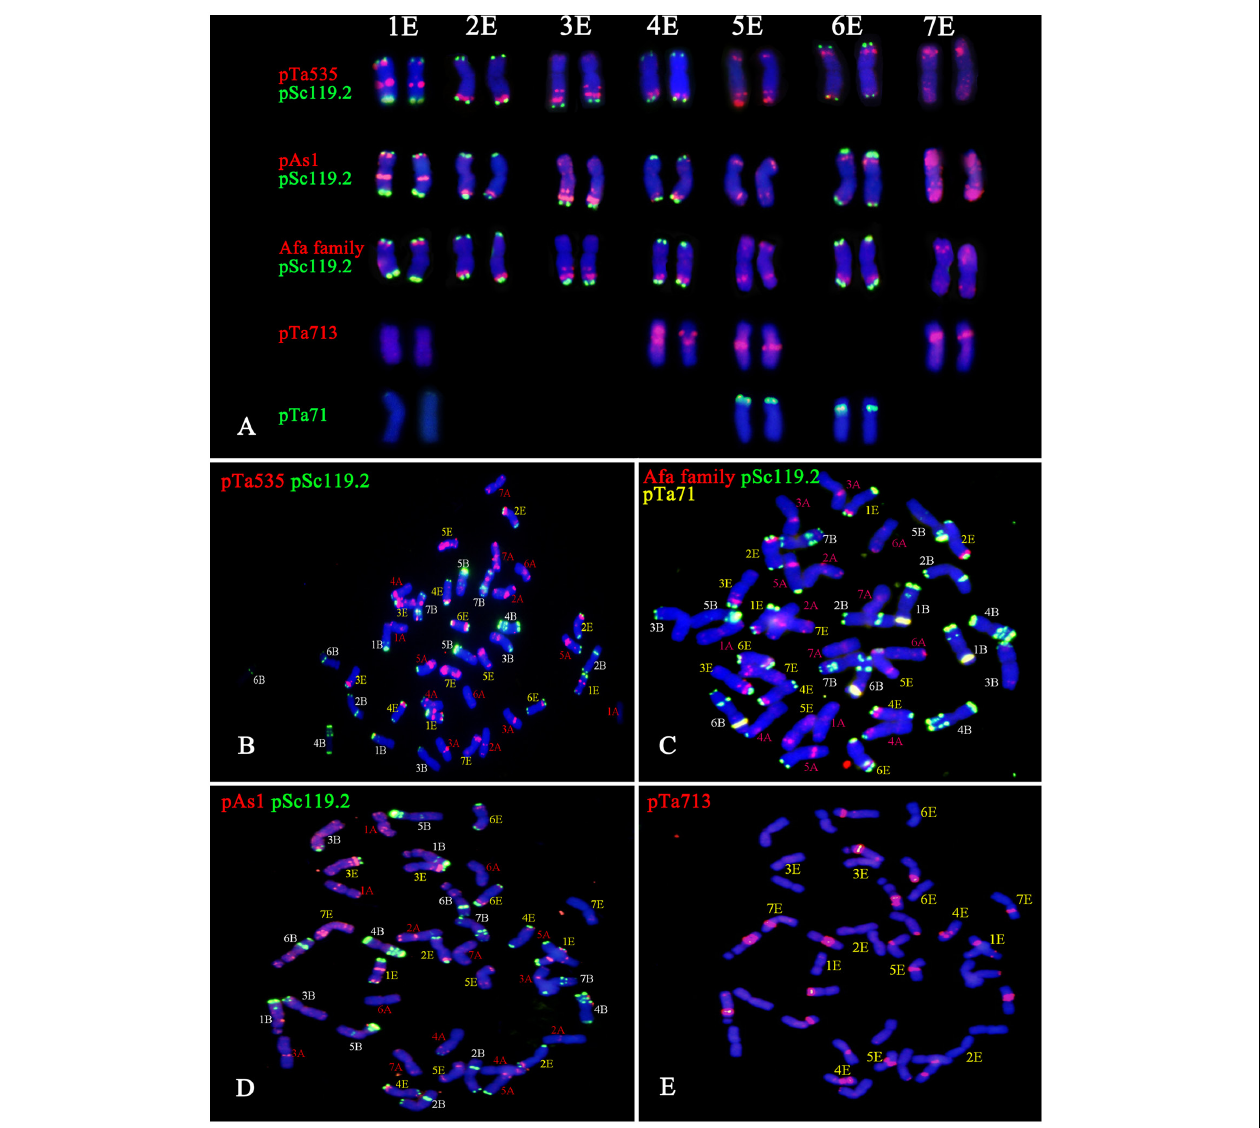
FIGURE 2 | FISH patterns of oligo probes in Trititrigia 8801. (A) FISH patterns of the 1E-7E chromosomes using pSc119.2 (green), pTa535 (red), Afa family (red), pAs1 (red), pTa713 (red), and pTa71 (green). (B) FISH identification of 8801 using pTa535 (red) and pSc119.2 (green). (C) FISH identification of 8801 using Afa family (red), pSc119.2 (green), and pTa71 (yellow). (D) FISH identification of 8801 using pAs1 (red) and pSc119.2 (green). (E) FISH identification of 8801 using pTa713 (red).